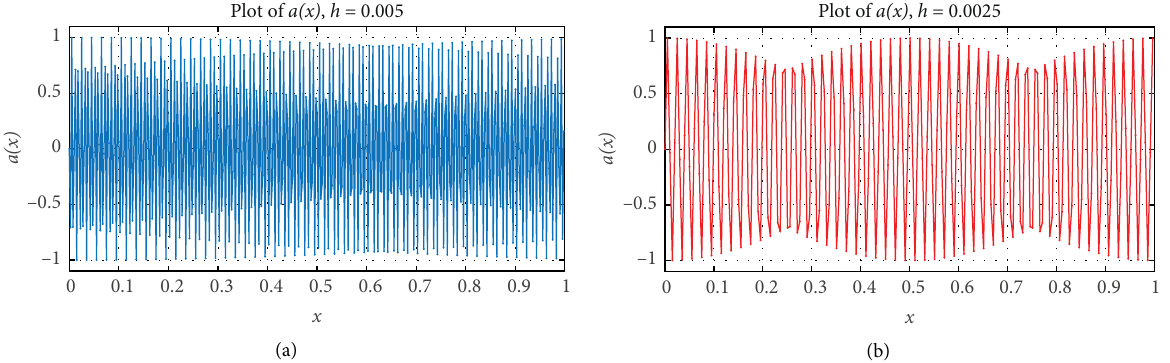
vs approximate solutions 𝑢(𝑥)